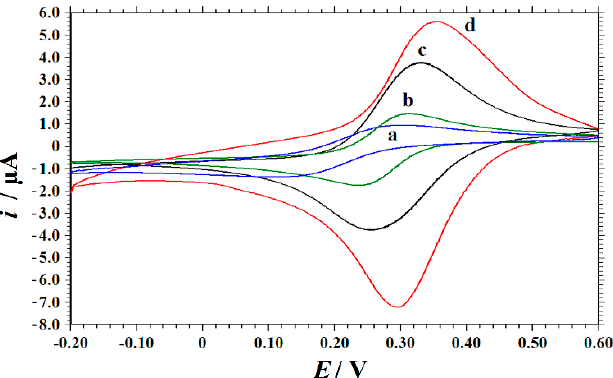
Figure 4. The cyclic voltammograms obtained at di ff erent electrodes in the 1.0 mM K 3 [Fe(CN) 6 ] solution containing 0.5 M KCl. ( a ) CPE, ( b ) ABPE, ( c ) MIP / ABPE before extraction, ( d ) MIP / ABPE after extraction. Scan rate: 0.1 V s −